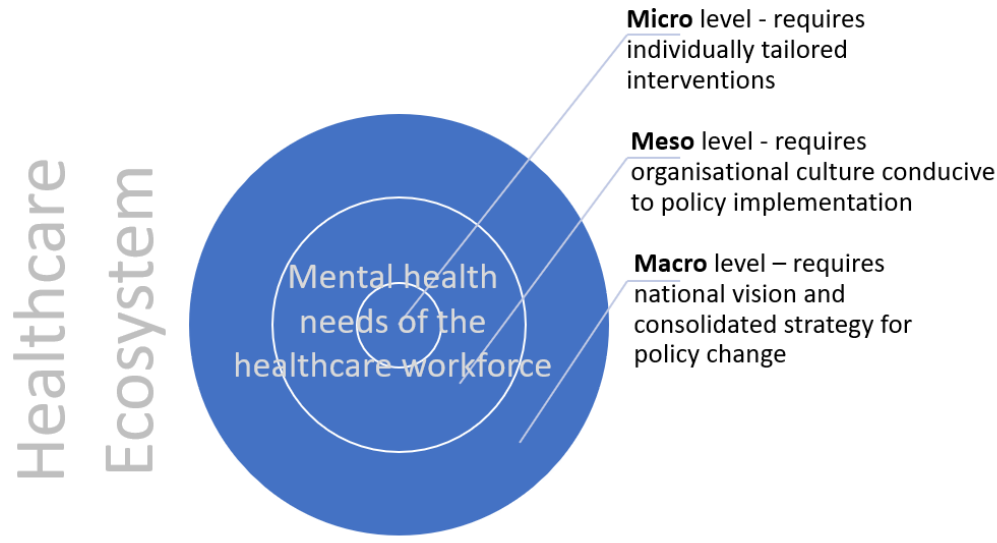
Figure 2. Healthcare ecosystemic model of mental health needs of healthcare workers.